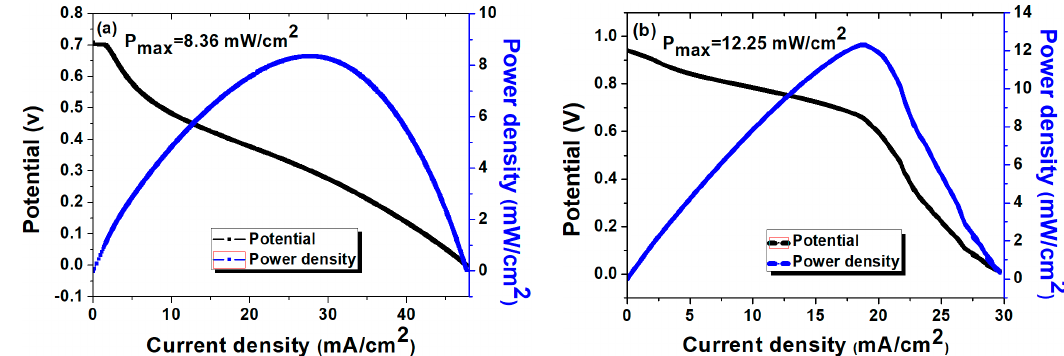
Figure 7. Polarization and power density curves of urea/O 2 fuel cells operated using ( a ) qPPO/D-Cel7 and ( b ) qPPO/DG-Cel7 as AEM using urea (0.33 mol L − 1 ) in aqueous KOH solution (3 mol L − 1 ) as anolyte and moisturized O 2 as the catholyte at 70 °C.